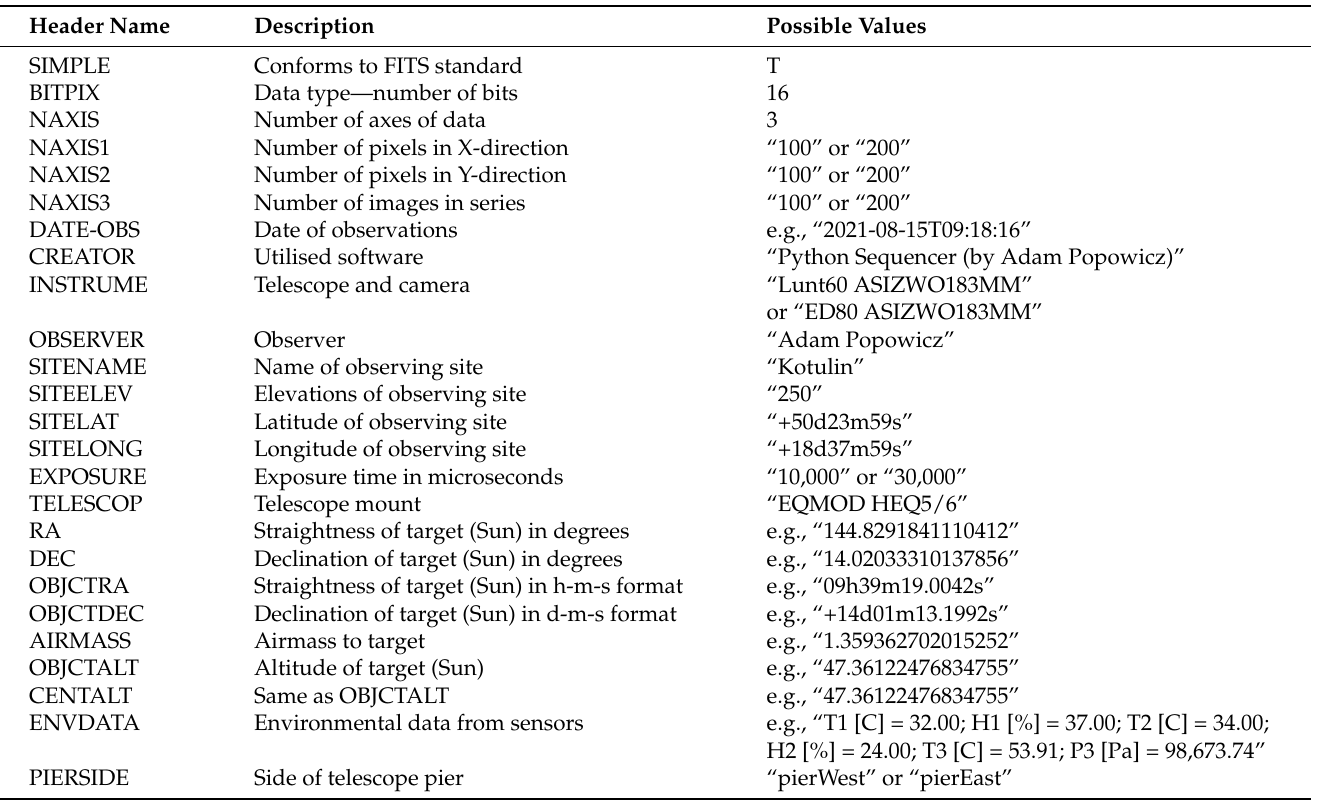
Table 4. Description of headers in raw FITS